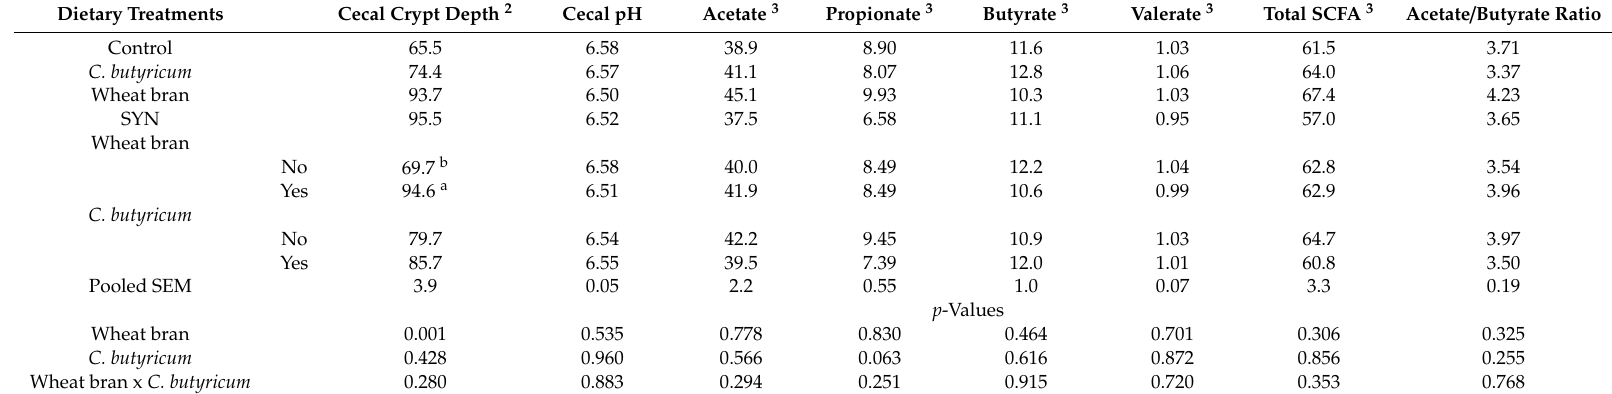
Table 4. E ff ect of wheat bran and Clostridium butyricum ( C. butyricum ) supplementation on cecal histological and physicochemical characteristics in broiler chickens at 37 days of age 1 . Dietary Treatments Cecal pH Acetate